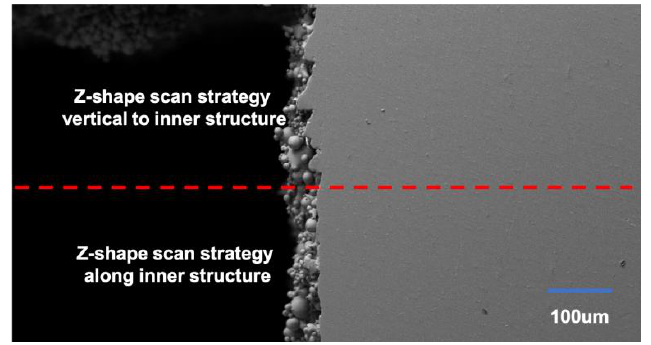
Figure 8. The morphology of the side surface printed using different scan strategies.